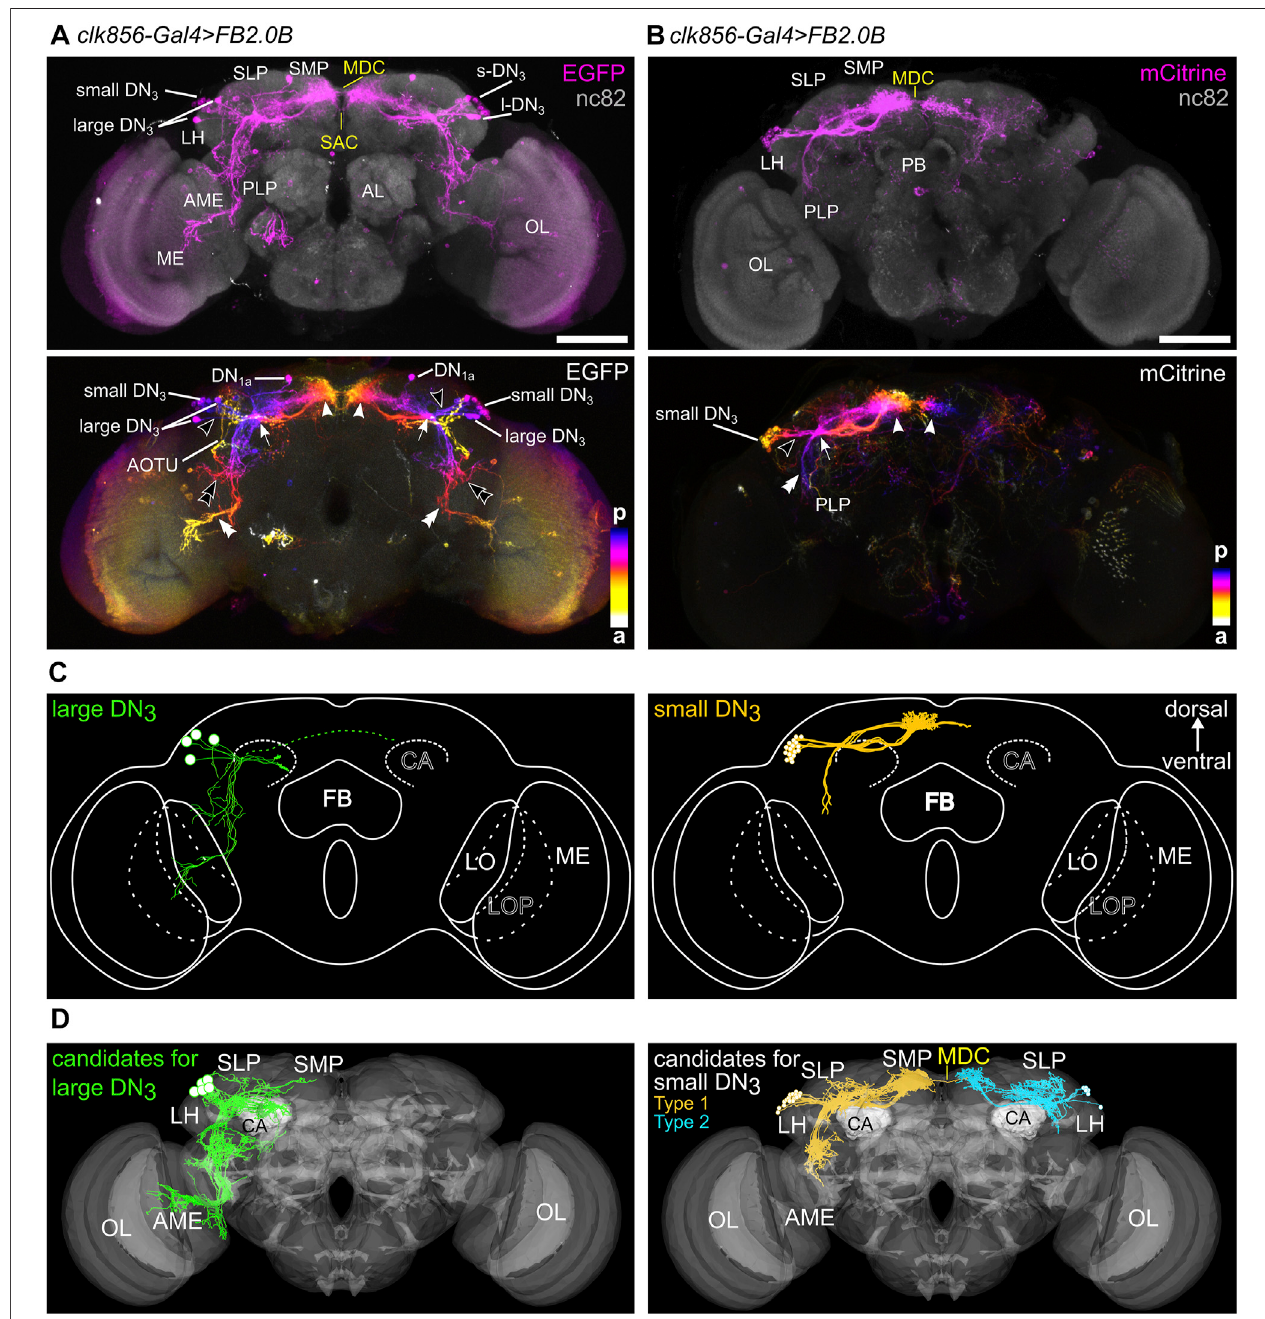
FIGURE 14 | The morphology of the DN 3 subclasses. (A , B) Two exemplary brains, which express the Flybow-reporters in different subsets of DN 3 (maximal projections of57 (A) and 32 (B) confocal planes). The upper panel shows an overlay withneuropil counterstaining (nc82), the lowerpanel shows theneurons with color- coded depth information. Fibers in the posterior (p) brain are marked blue and fi bers further anterior (a) are marked in yellow/white. (A) Fibers in the accessory medulla (AME) couldonly beobservedinbrains, inwhichthelargerDN 3 swerelabeled.Likewise,theprojections throughthe superiorarch commissure (SAC) areabsent in brains,inwhichthelargeDN 3 sarenotlabeled (B) . (B) ArborizationpatternofthesmallDN 3 s.Theprojectionsofthesecellsintheposteriorlateralprotocerebrum(PLP)do notinvadetheAME.The fi bersrunthroughthemiddledorsalcommissure(MDC),butnot via theSACintothecontralateralhemisphere. (C) Estimated projectionpattern ofthe large and small DN 3 s.All DN 3 shave arborizationsinthe dorsalbrain,but thecontributiontotheSAC isuniquetothelarger cells. Theoverlap with projections from other neurons (mainly small DN 3 s) made further analysis of the DN 3 arborization pattern in the dorsal brain impossible (indicated by dashed line). (D) Reconstruction of potentialDN 3 candidates fromthehemibrain.Accordingtotheirmorphology,theputativeDN 3 scanbedividedintothreesubtypes(green,yellow,cyan).Whilethegreen neurons look similar to the above-described morphology of the large DN 3 s the yellow neurons resemble the described morphology of the small DN 3 s (compare with C ). The cyan depicted neurons are not matching the described morphologies based on the Flybow staining. They possess the arborization pattern of the small DN 3 s in the